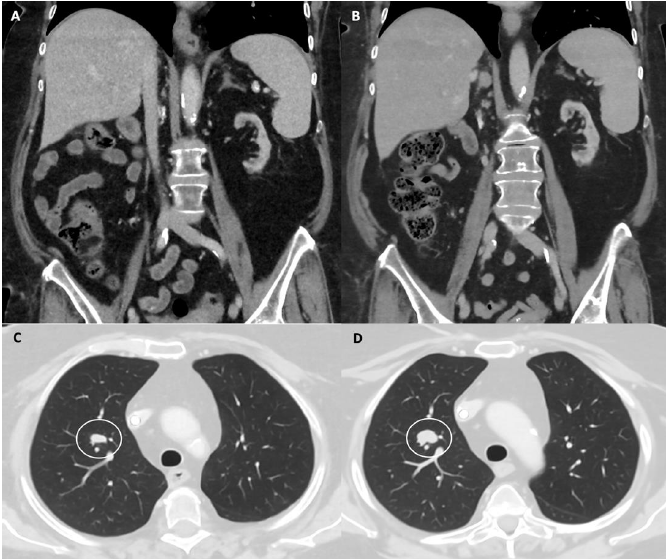
Figure 3. CT scans in a female patient, 80 years old with metastatic RCC in the right lung before ( A , C ) and after medical treatment ( B , D ). CT images are reported in coronal views ( A , B ) obtained with multiplanar reformation and in axial views ( C , D ). The patient underwent right nephrectomy for the primary tumor (clear cell RCC) ( A , B ) and was medically treated initially with a flat dose of nivolumab (480 mg/4 weeks). CT images before medical therapy showed the presence of a lung nodule in the superior right lobe ( C , white circle) that showed a 60% increase in size (10 mm vs. 16 mm) after medical treatment ( D , white circle) reflecting an immune-unconfirmed progressive disease according iRECIST (Table 2).